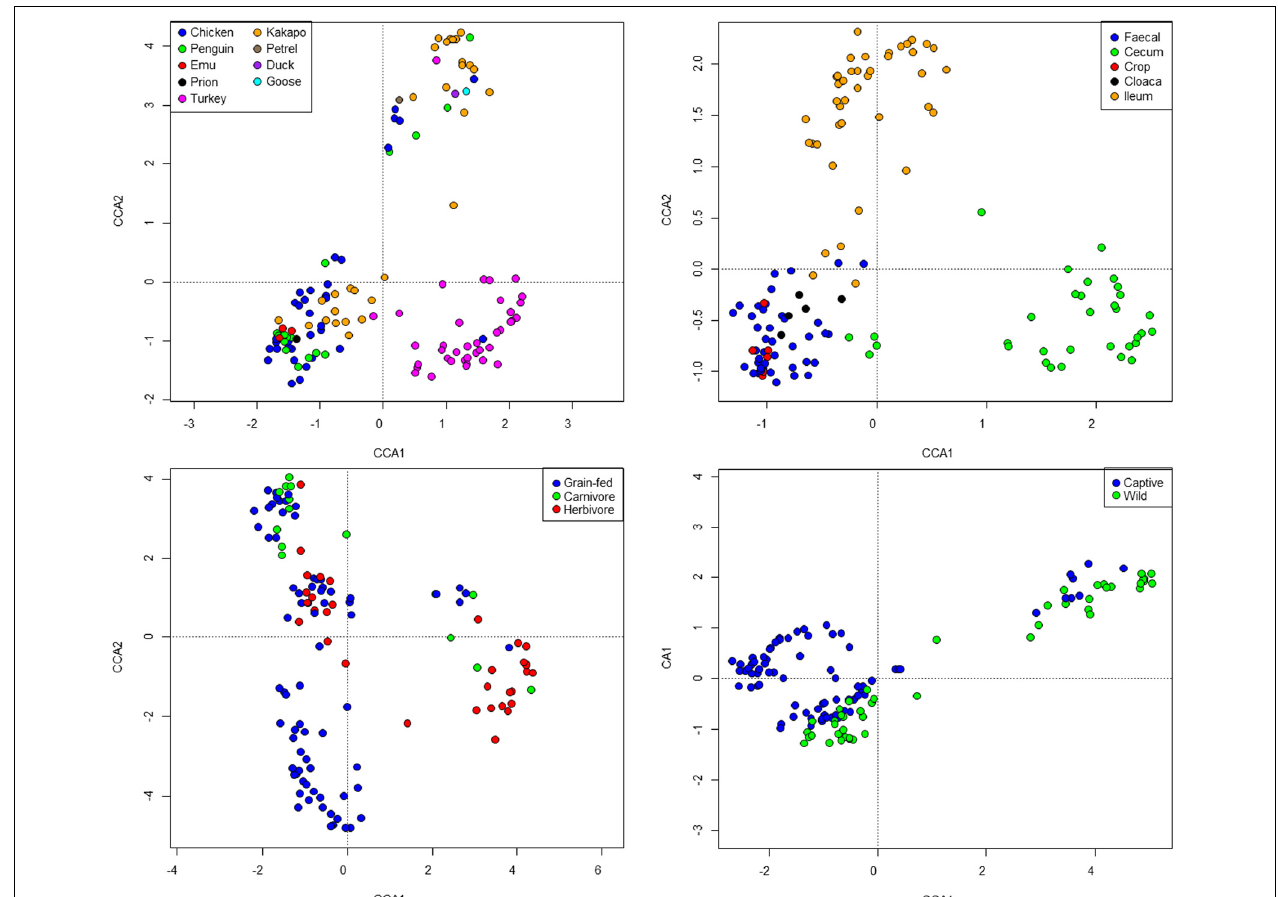
FIGURE 4 | Constrained Canonical Analysis of community structure based on fitting of metadata factors to the short-read sequence data. Images represent host (top left),